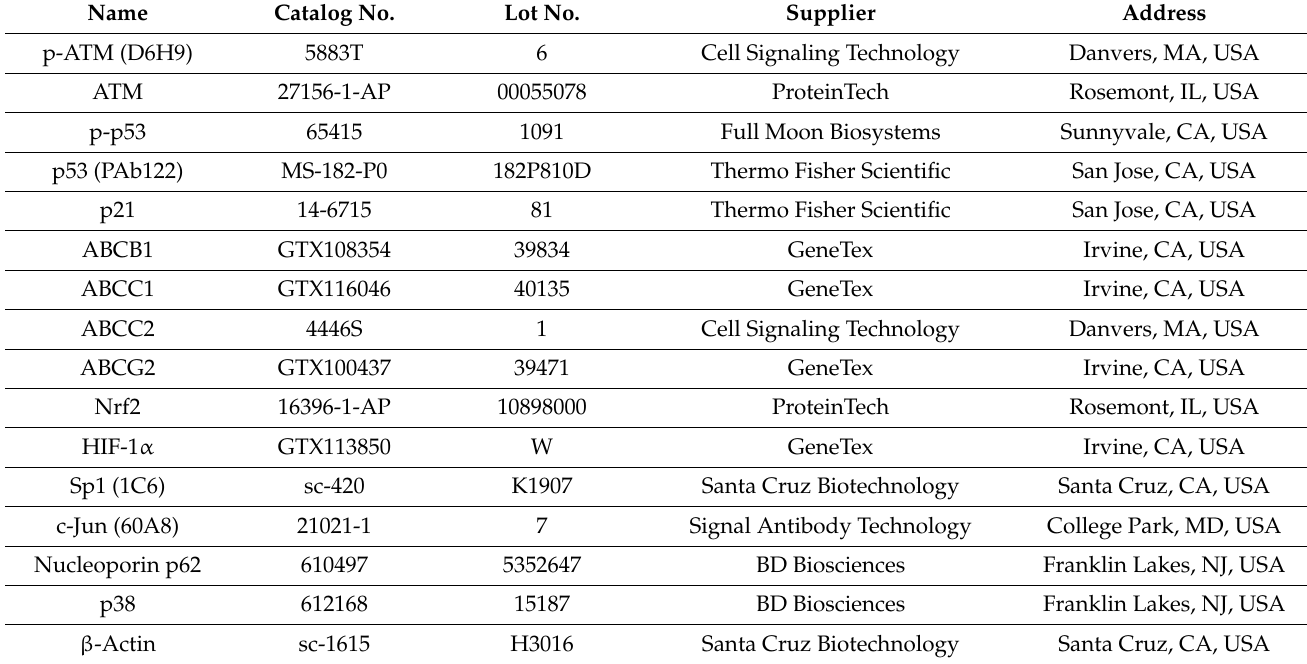
Table 2. Primary antibodies for Western